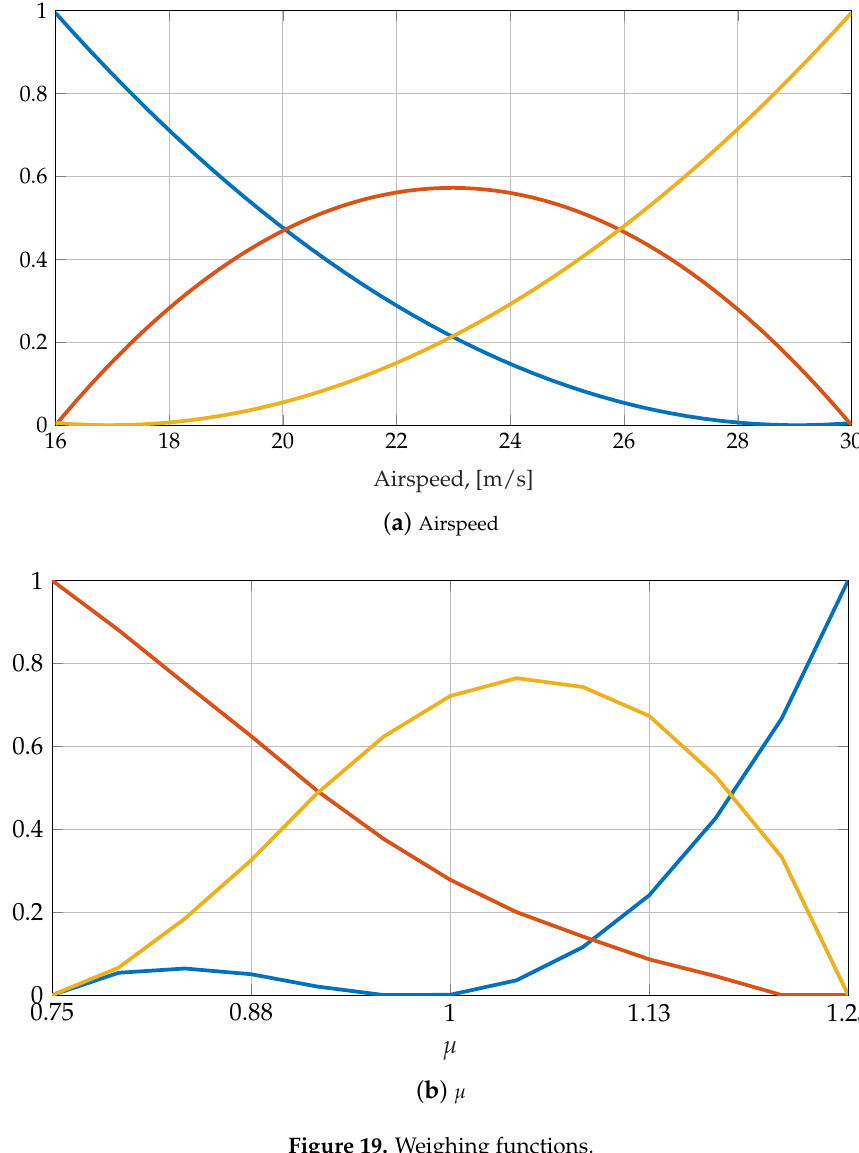
Figure 19. Weighing